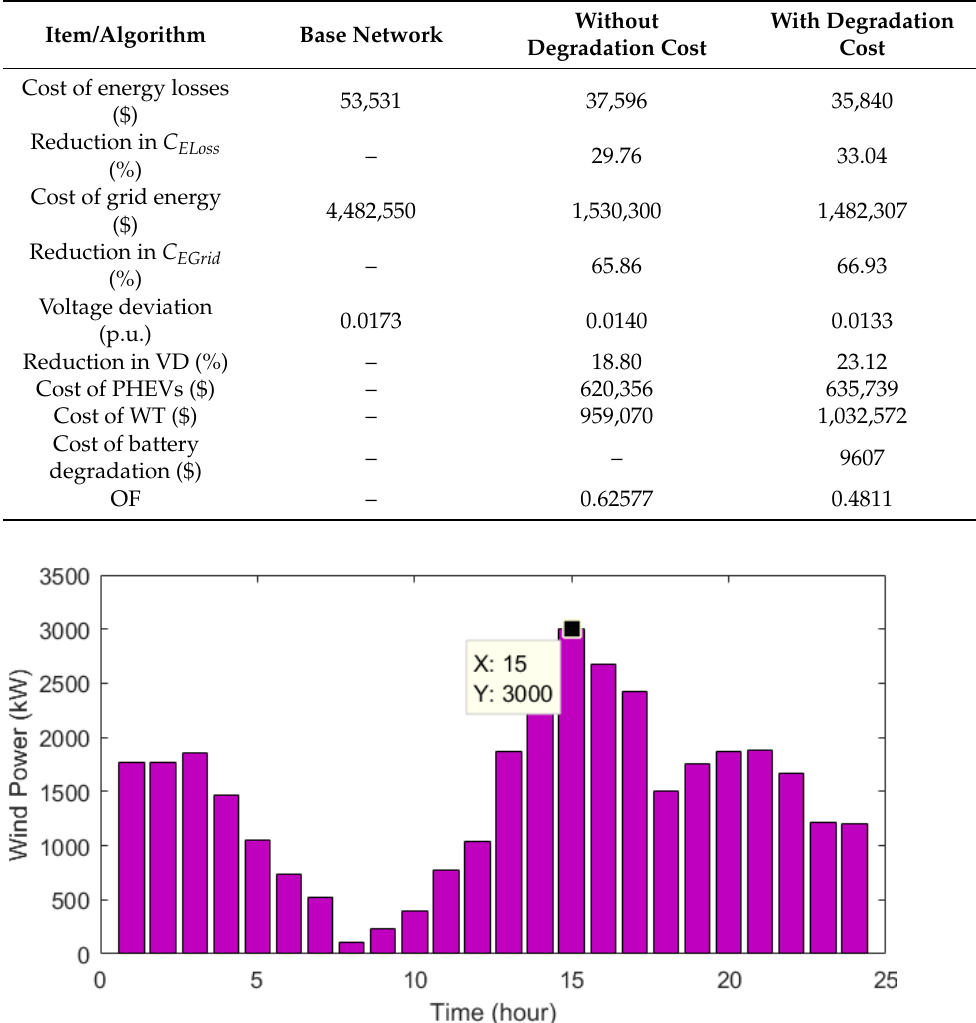
Table 7. The results of WT and PHEV scheduling in the distribution network without and with battery degradation cost.